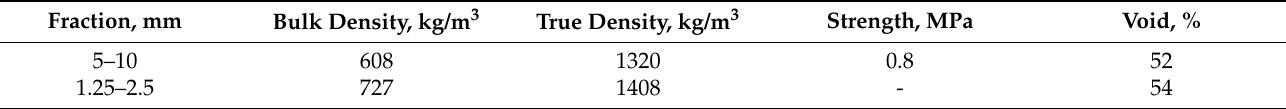
Table 10. Physical and mechanical characteristics of slag